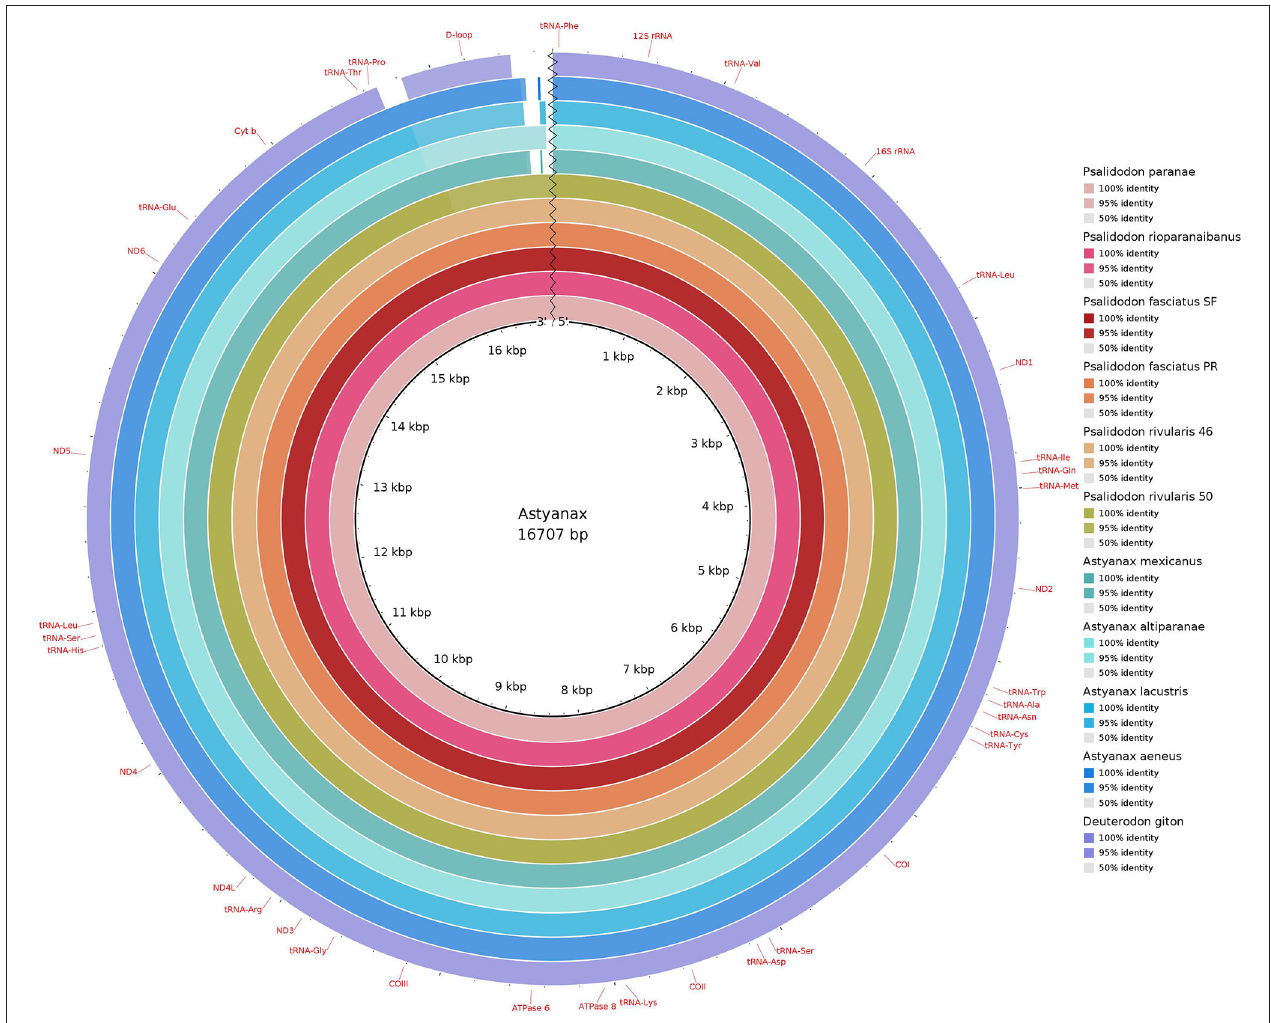
FIGURE 2 | Comparative mitogenomics analysis of all the 10 Stethaprioninae fish against a reference ( Psalidodon paranae ), generated by Blast Ring Image Generator (BRIG). Gaps in rings correspond to regions with <50% identity to the reference sequence (BLAST comparison). Colors from the center: dd9998; cb3b54; a31418; e85e25; df9856; 95ac42; 38a67f; 79bdbe; 00a8c3; 016db8; 6c5ab1.